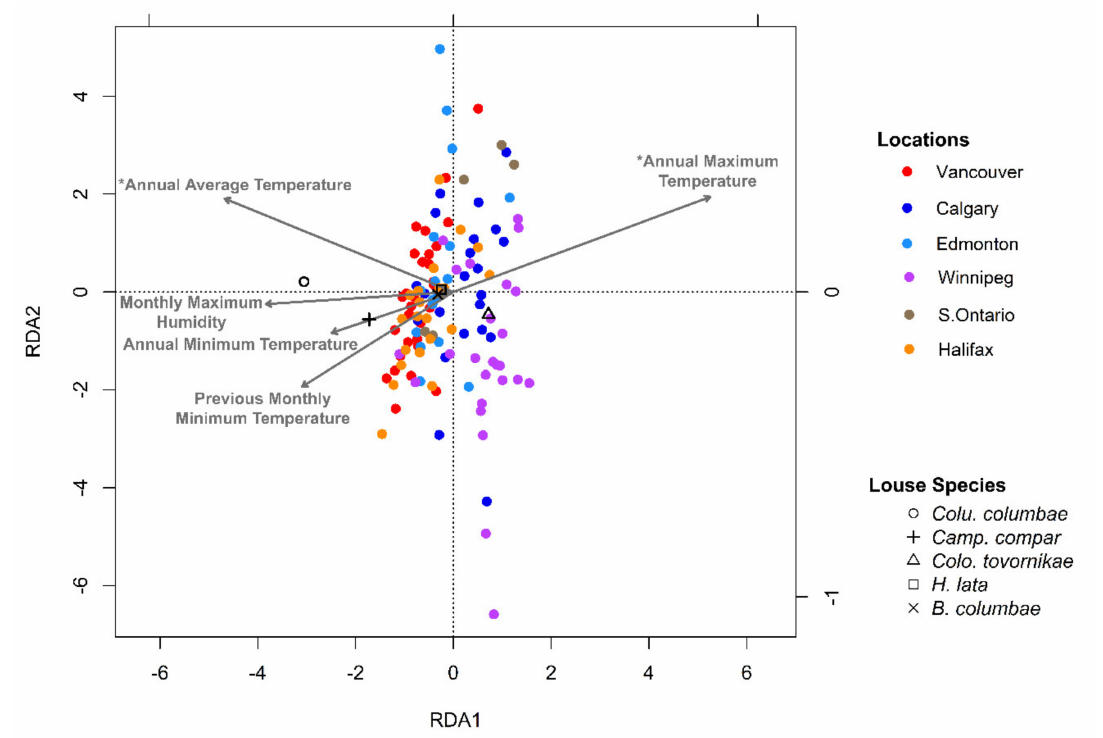
Figure 9. Redundancy analysis plot of louse assemblages (abundance data log (x + 1) transformed) from Columba livia sampled from six locations across Canada. Vectors are meteorological variables chosen through forward selection. An asterisk (*) indicates a p -value < 0.05 after correction for multiple